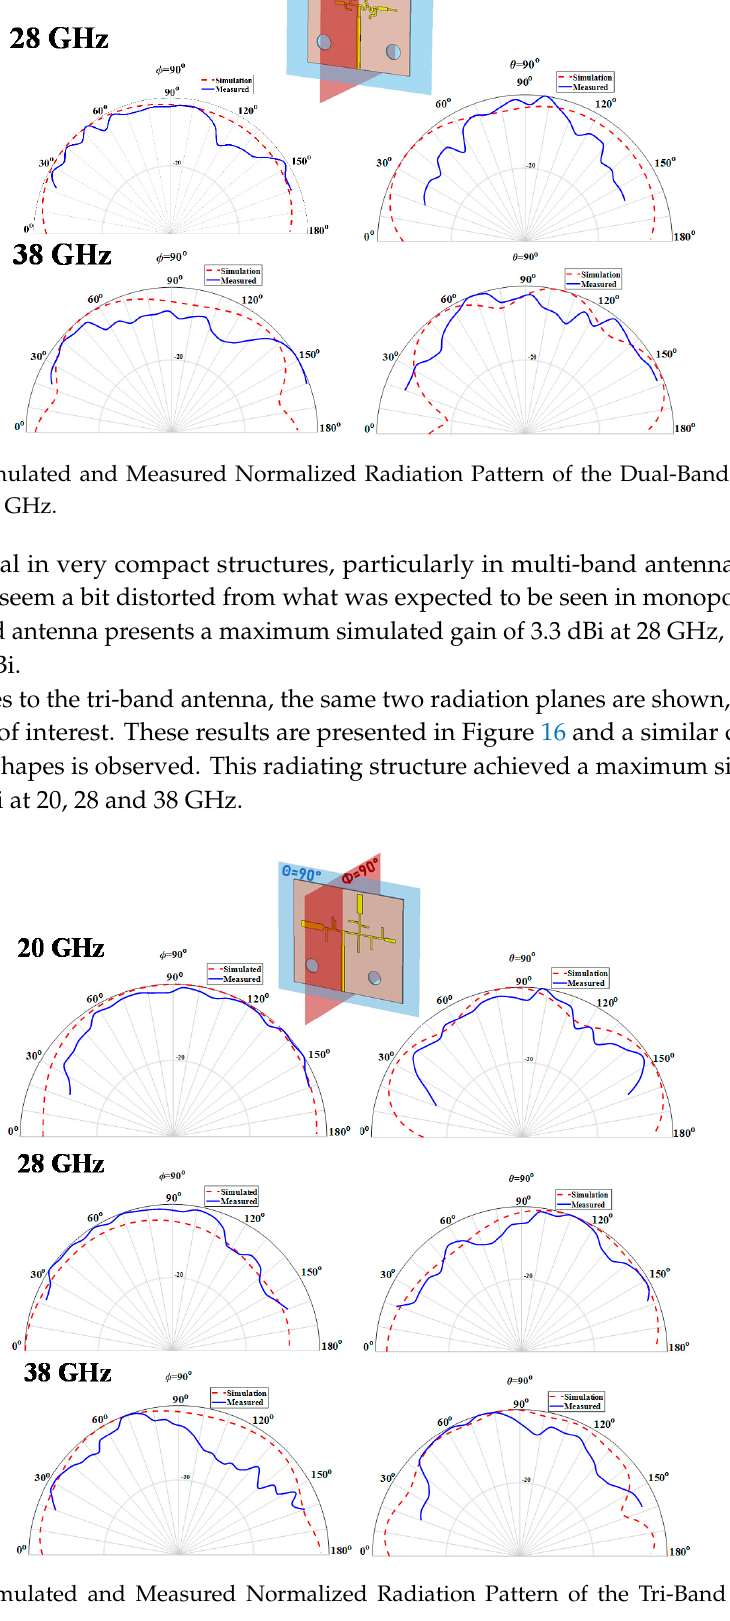
Table 5. State-of-the-Art of Multi-Band Antennas: Main Results. [Ref.] PY